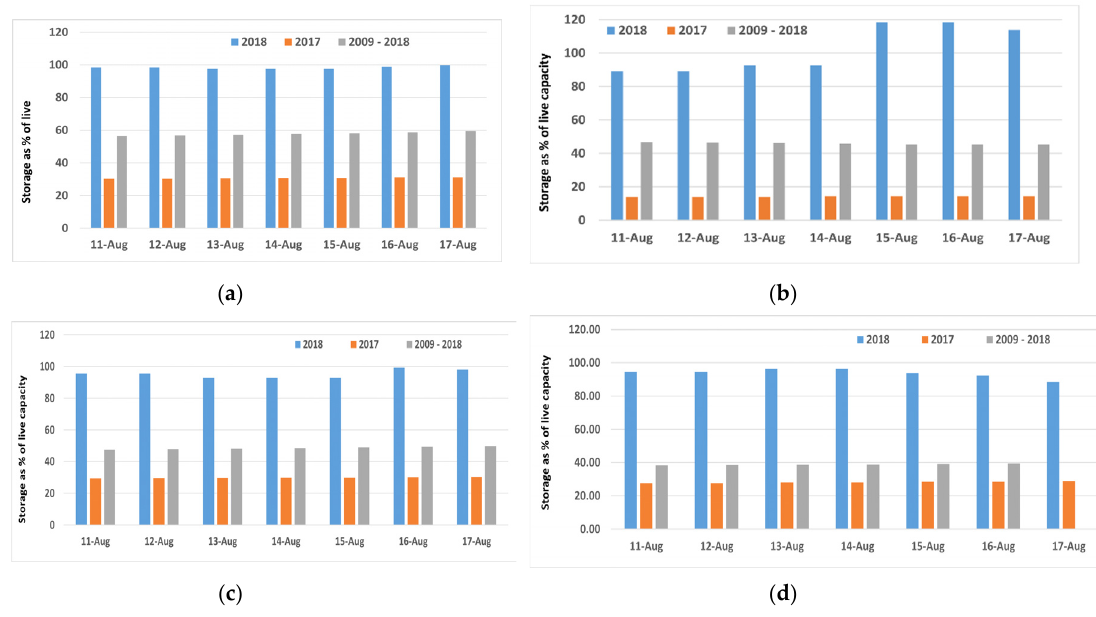
Figure 11. ( a – d ). The storage capacity of four reservoirs/dams in Kerala: ( a ) Kakki, ( b ) Periyar, ( c ) Idukki, and ( d ) Malampuzha.